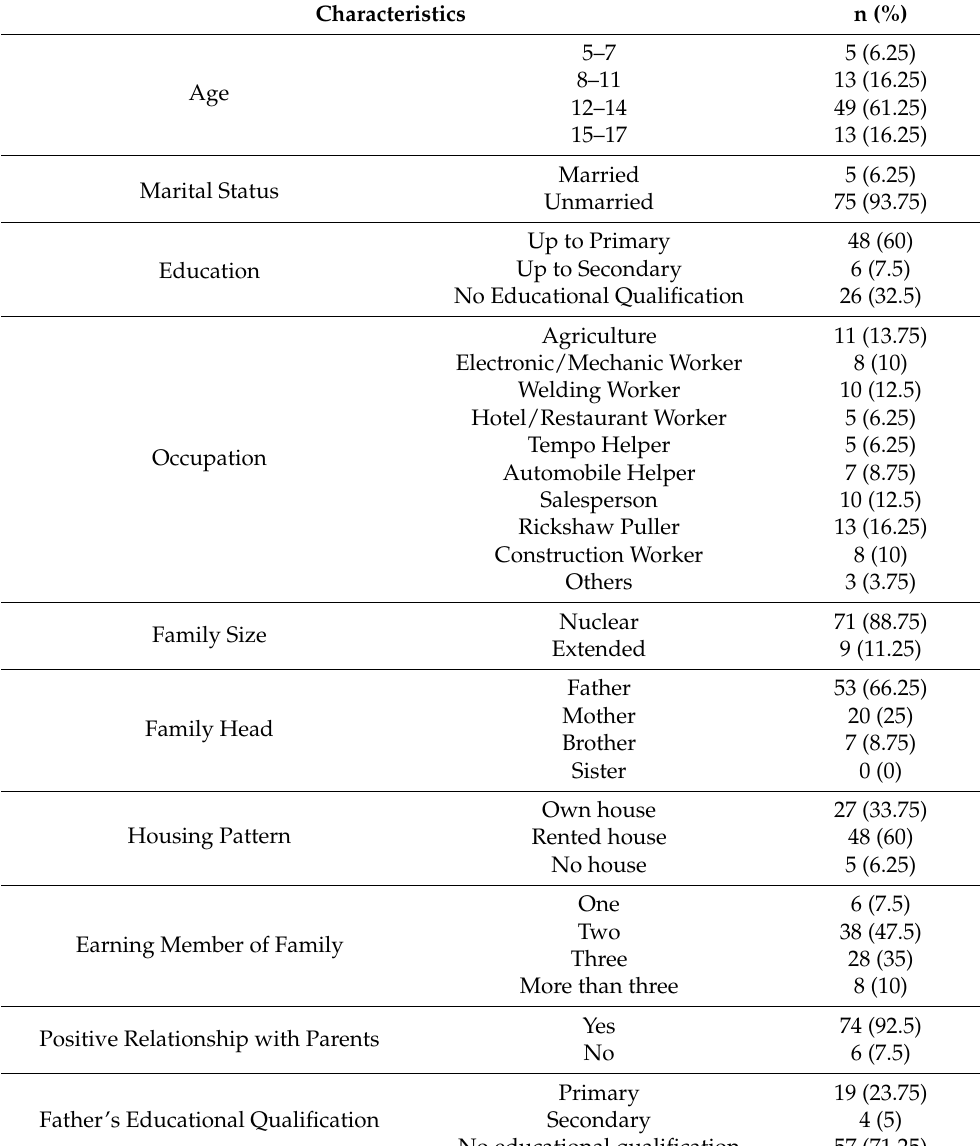
Table 1. Socioeconomic Information of Child